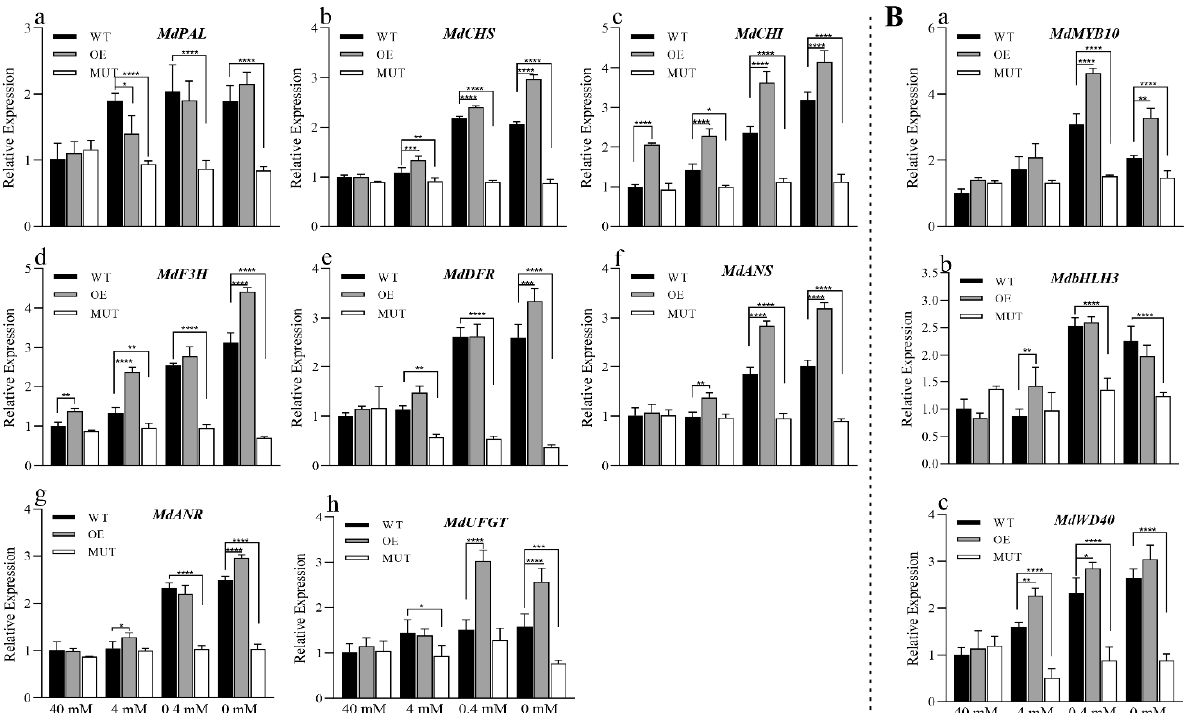
Figure 8. Expression levels of structural genes related to anthocyanin synthesis in the calli of wild-type (WT) plants, transformed CRISPR/Cas9- MdMKK9 (MUT) lines, and transformed pRI101- MdMKK9 (OE) lines grown in mediums with different nitrogen concentrations. ( A ) Relative expression of structural genes involved in anthocyanin synthesis ( a : MdPAL , b : MdCHS , c : MdCHI , d : MdF3H , e : MdDFR , f : MdANS , g : MdANR , h : MdUFGT ). ( B ) Relative expression of regulatory genes related to anthocyanin synthesis ( a : MdMYB10 , b : MdbHLH3 , c : MdWD40 ). The relative level of anthocyanin synthesis-related genes in 40 mM NO 3 − treated WT calli was set to 1. The bars represent means ± SD ( n = 3). Asterisks indicate statistically significant differences (* p < 0.05; ** p < 0.01; *** p < 0.001; **** p < 0.0001). Overall, the expression levels of nitrogen transport-related genes in WT, OE and MUT calli decreased with decreasing nitrogen concentration of the medium (Figure 9).